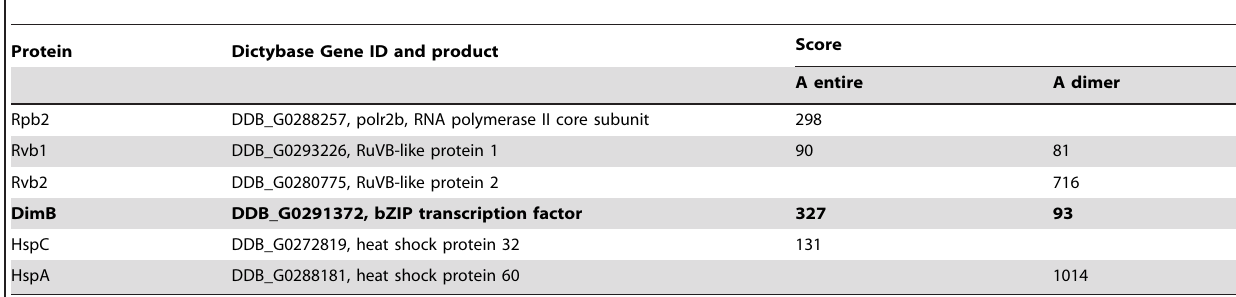
Table 1. Mass spectrometry scores for selected of the proteins purified by affinity chromatography using region A.